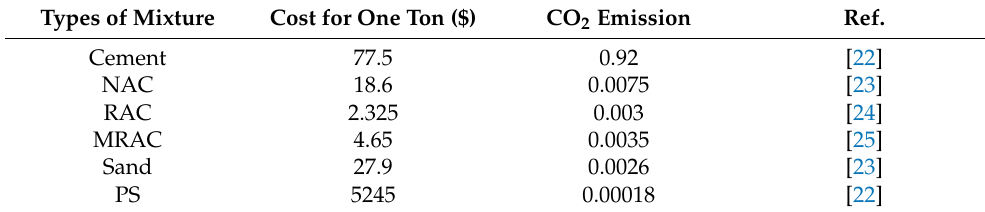
Table 5. Cost and carbon dioxide emissions of the raw